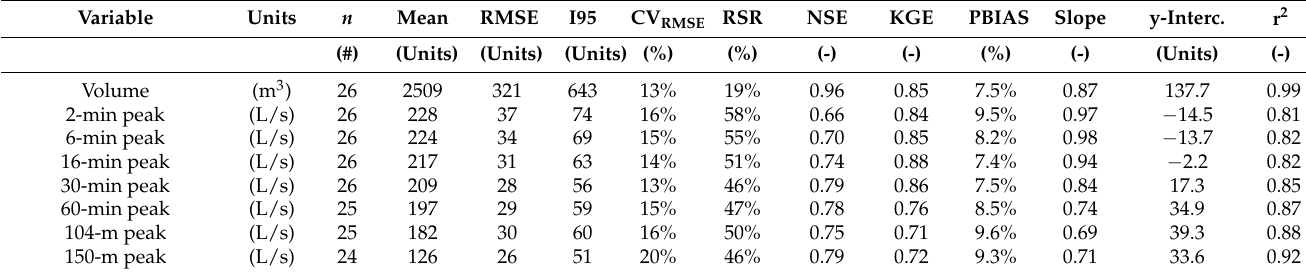
Table 2. Example of the application of the metrics described in Section 2 according to the proposed new